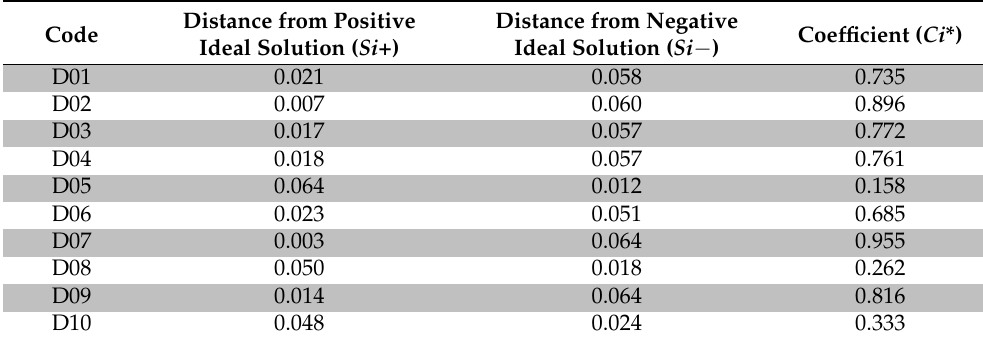
Table 7. Distances from the positive ideal solution, distance from the negative ideal solution, and the Ci* coefficient.